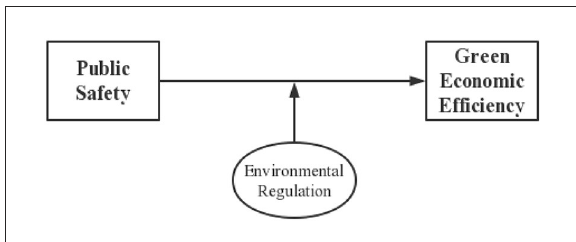
factor calculated in the first stage, and Z ik is the vector of external environment variables, and α i is the constant term, and β i is the vector of coefficients to be estimated, and µ i is the random disturbance term.